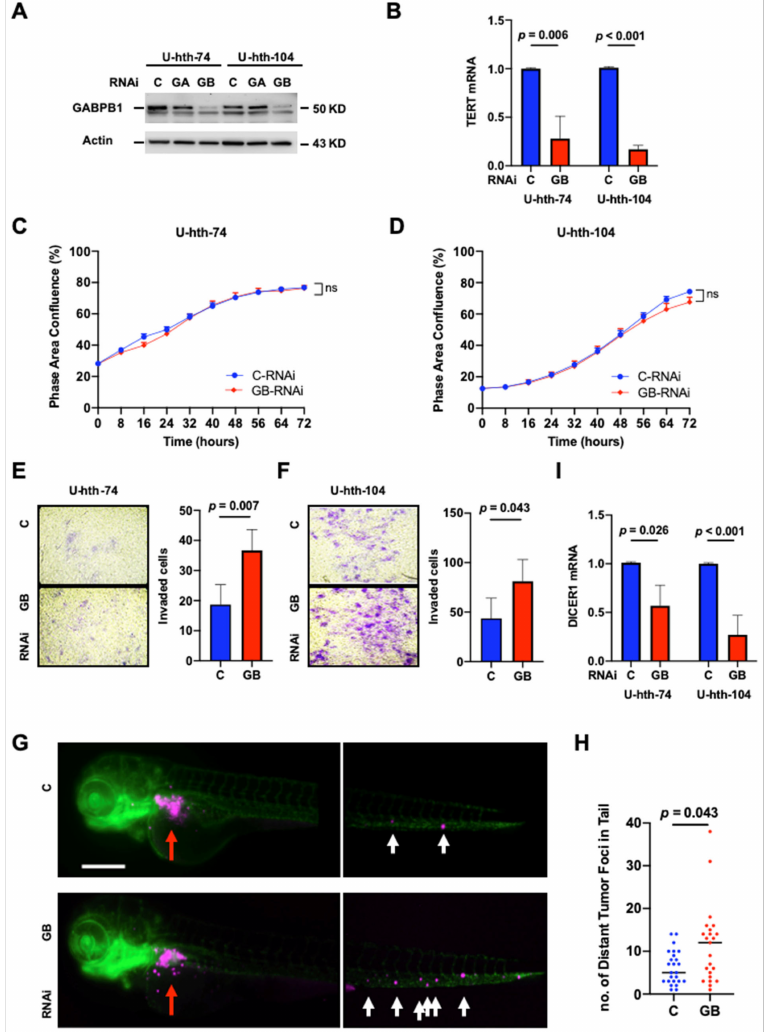
Figure 1. GABPB1 depletion leads to diminished TERT and DICER1 expression but promotes inva- siveness and distant metastasis of TC cells. U-hth-74 and U-hth-104 cells were transfected with control and GABPB1 RNAis, respectively, and harvested for analyses at 48 h. Three independent experiments were performed. ( A ) Verification of GABPB1 knockdown efficiency using immunoblotting. RNAi to GABPA was also included as an additional control to support the RNAi specificity. Original Images for Western blots are shown in Figure S7. ( B ) Downregulation of TERT mRNA expression in GABPB1-depleted cells. qPCR was performed to determine mRNA levels. ( C , D ) Proliferation analy- ses of GABPB1-depleted U-hth-74 and U-hth-104 cells. ( E , F ) Enhanced invasion of GABPB1-depleted U-hth-74 and U-hth-104 cells. Matrigel assays were used to determine invasive potentials of cells. ( G ) Knocking down of GABPB1 in U-hth-104 cells promotes distant metastasis in a zebrafish xenograft model. Representative fluorescence (Magenta) images of U-hth-104 cells injected into perivitelline space (red arrow) of zebrafish larvae 48 h post fertilization under 10X objective. White arrow marks distant tumor foci quantified after 24 h post injection. Scale bar denotes 200 µ m ( H ) Numbers of tumor foci found in the tails of zebrafish larvae. ( I ) Downregulation of DICER1 mRNA expression in GABPB1-depleted cells. C: control; GA: GABPA; GB: GABPB1; ns: not significant; no: